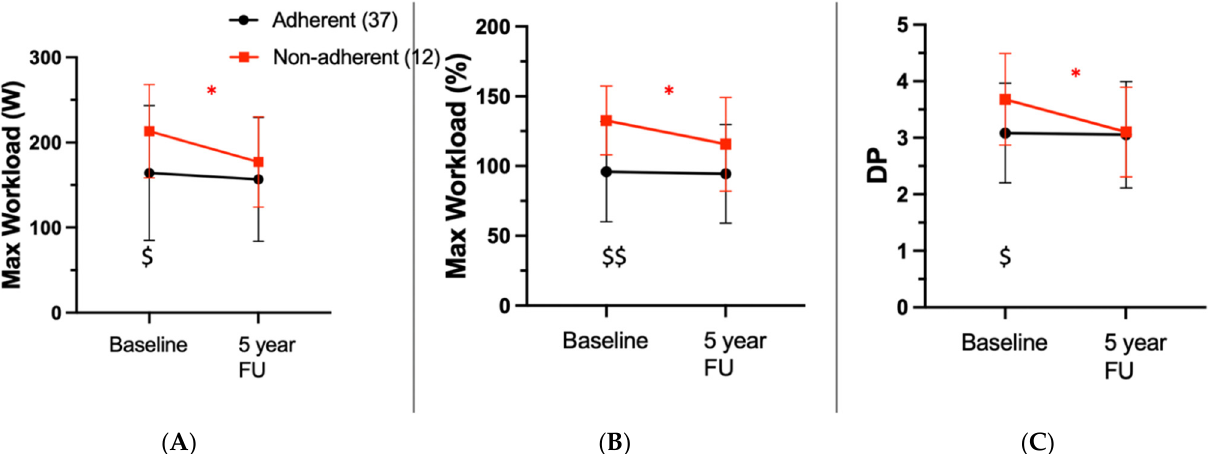
Figure 1 . Exercise testing findings. ( A ) Comparison of maximum Workload (W) at baseline and follow-up. ( B ) Comparison of maximum Workload (%) at baseline and follow-up . ( C ) Comparison of double product (DP) factor at baseline and follow-up . Red line indicates cohort, who continued physical activity (non-adherent); black line indicates cohort, who stopped physical activity (adherent). * indicates p < 0.05 for paired t -test. $ indicates p < 0.05, $$ indicates p < 0.005 for independent Student’s t-tests between the two cohorts.